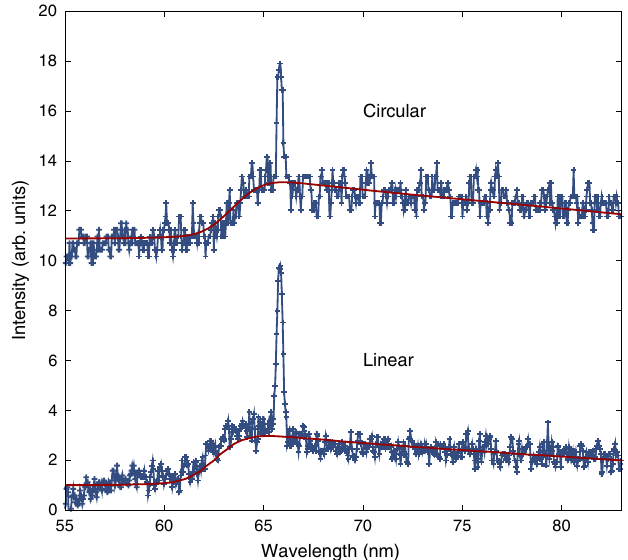
FIG. 5. Coherent 4th harmonic in circular and linear polariza- tion. The full lines indicate the expected incoherent undulator harmonic according to SPECTRA simulations. The coherent gain is of the same order of magnitude in both cases and its difference is within the margins of overall stability fluctuations of the system.